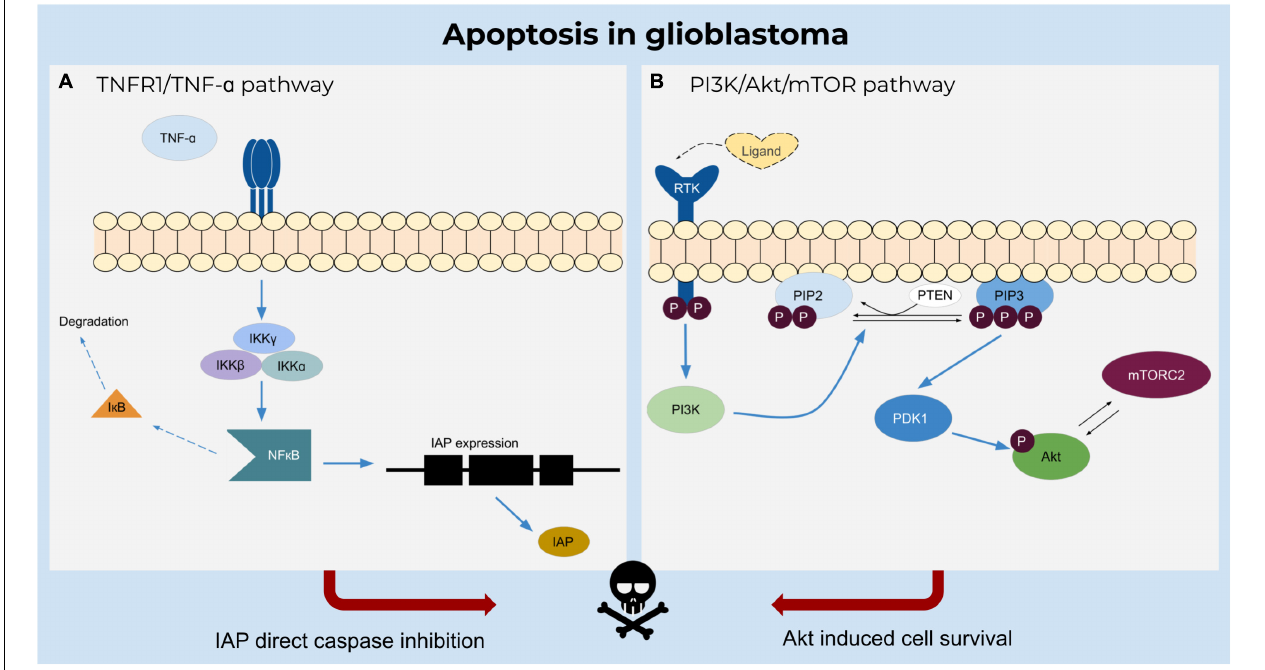
FIGURE 2 | Apoptosis in glioblastoma. (A) TNF- α induces inhibition of caspases by activating NF κ B upon binding to TNFR1 receptor and triggering the IKK complex to degrade the inactivating factor I κ B. NF κ B regulates the expression of IAPs which inhibit apoptosis. (B) Ligand binding to the receptor tyrosine kinase